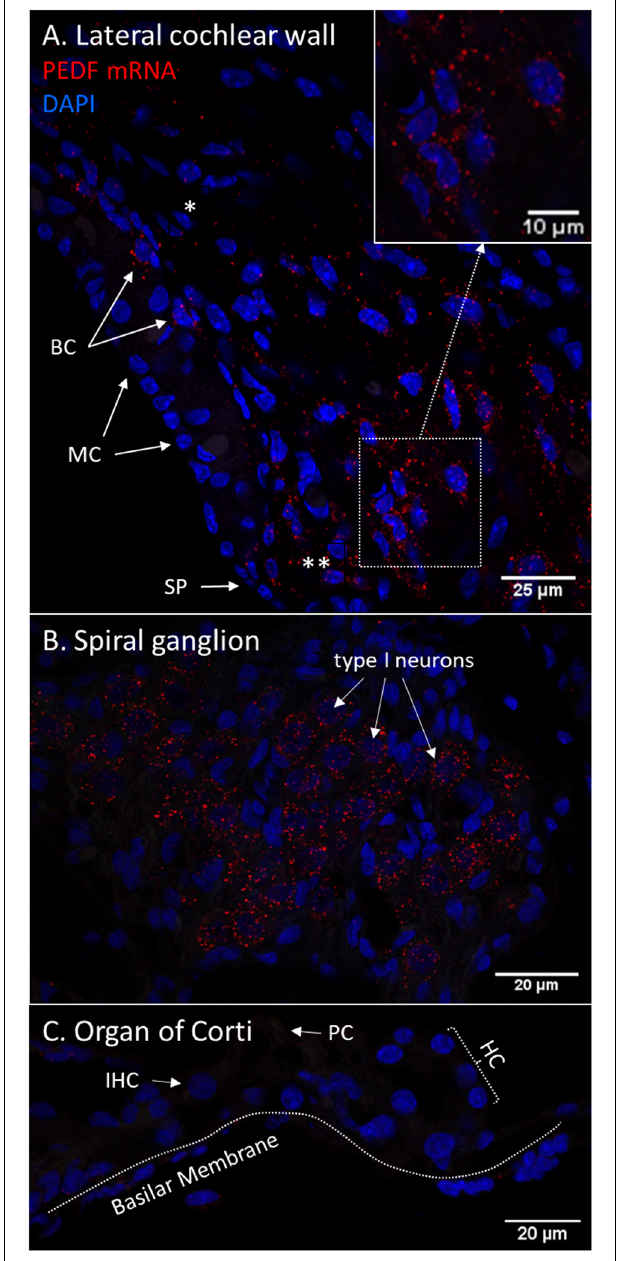
FIGURE 12 | (A–C) RNAscope of PEDF mRNA in the normal guinea pig cochlea. Red dots indicate mRNA transcripts. DAPI staining of nuclei. Spiral prominence (SP); Marginal cell (MC); Basal cell (BC); Hensen’s cells (HC); type I fibrocytes ( ∗ ); type II fibrocytes ( ∗∗ ). (A) PEDF mRNA transcripts were found in the stria vascularis, spiral ligament, and spiral prominence. The type II fibrocytes had the most abundant transcripts. Transcripts were detected in type I fibrocytes in the basal layer of the stria vascularis. (B) The spiral ganglion type I neurons demonstrate high numbers of PEDF mRNA transcripts. (C) No PEDF mRNA were found in the organ of